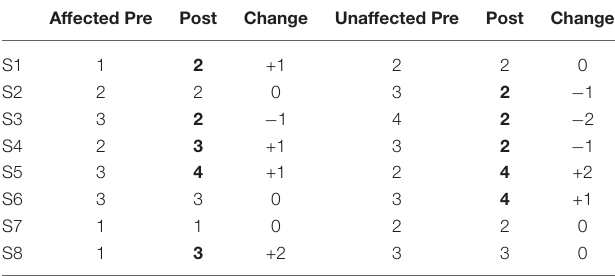
Bold numbers indicate the change in the number of muscle synergies.